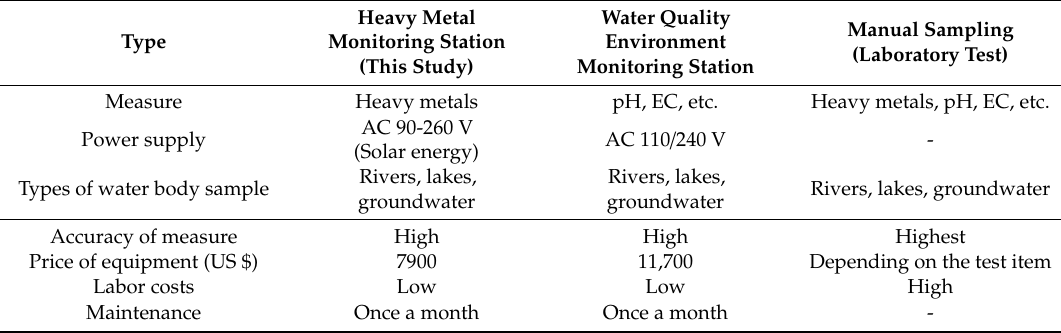
Table 4. Comparison of commonly used stations for water quality